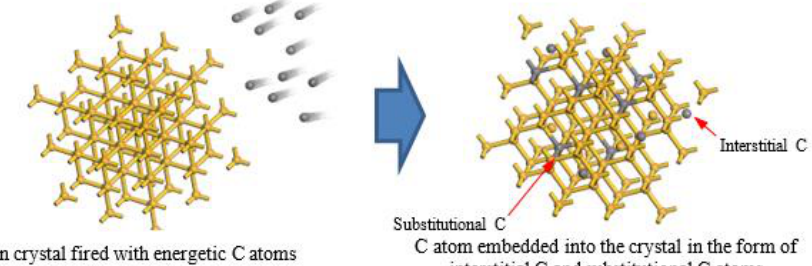
Figure 1. Lattice structure formation during carbon implantation. Carbon ion displaces the silicon from the lattice position to become carbon substitutional ( Cs ). The displaced silicon atom, called self-interstitial ( I ), can freely move between the lattice. Consequently, the mobile silicon ( I ) returns into the lattice site; thus, Cs becomes carbon interstitial ( Ci ). The interaction of CsCi with I has been proven to significantly increase the luminescence from silicon [3].